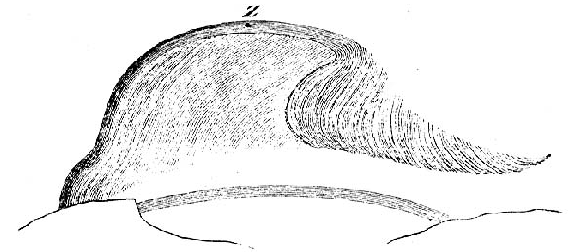
Fig. 16. Sketch of aurora on 29 November 1899 drawn by Sykora. Description of the event as viewed from Konstantinovka: “17:48 UT. An auroral band is situated from Chebyshev Mountain (East) through Zenith to West. Intensity: 3. Multiple arcs are near the horizon to the South. Intensity: 4. Diffuse aurora to the South.” Description of the same event as viewed from Treurenberg Bay: “17:45 UT. Form: a (arc), Structure: d (diffuse), Position (azimuth and elevation angles of two ends): a1 – 88, h1 – 0; a2 – S, h2 – 18, Intensity: